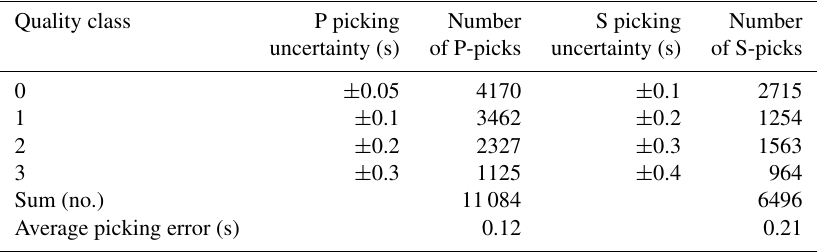
Table 1. Statistical parameters of high-quality P and S pick dataset of 301 well-constrained local earthquakes used for simultaneous inversion of hypocenters, 1-D velocity model, and station